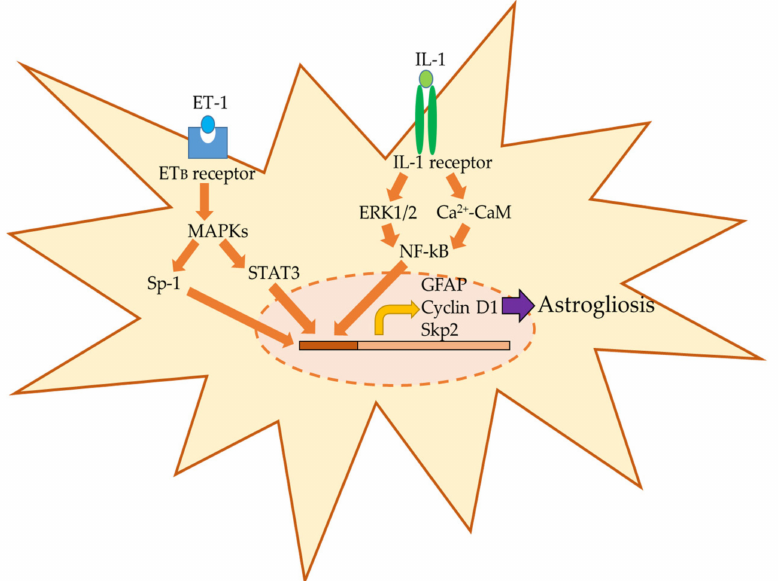
Figure 1. Expected mechanisms on astrogliosis in TBI. TBI promotes the expression of multiple bioactive factors such as endothelin-1 (ET-1) and interleukine-1 (IL-1). ET-1 and IL-1 bind to the ET B receptor and IL-1 receptor in astrocytes, respectively. Stimuli of these receptors activate the mitogen-activated protein kinase (MAPK) and Ca 2+ -calmodulin (CaM) pathways that promote the expression of glial fibrillary acidic protein (GFAP), cyclin D1, and S-phase kinase-associated protein 2 (Skp2) via activation of transcriptional factors including signal transducer and activator of transcription 3 (STAT3), specificity protein-1 (Sp-1), and nuclear factor- κ B (NF- κ B) in astrocytes, resulting in